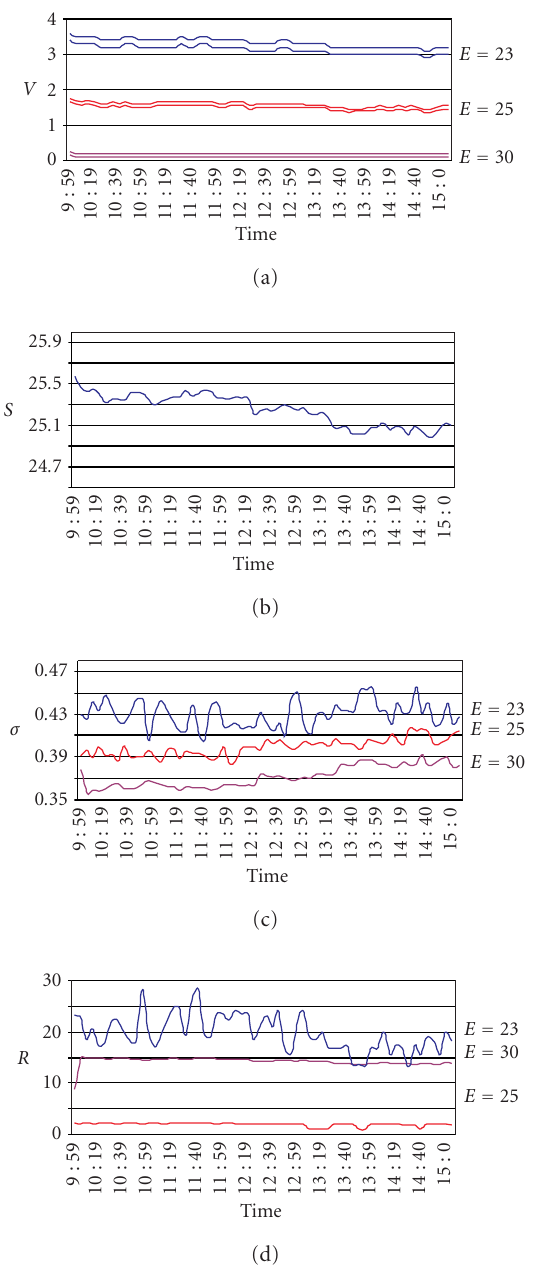
Figure 5.3. Intraday behavior of Microsoft stocks (April 4, 2003) and shortly expiring Call options with expiry date April 19, 2003, with computed implied volatilities σ RAPM and risk premium coe ffi - cients R